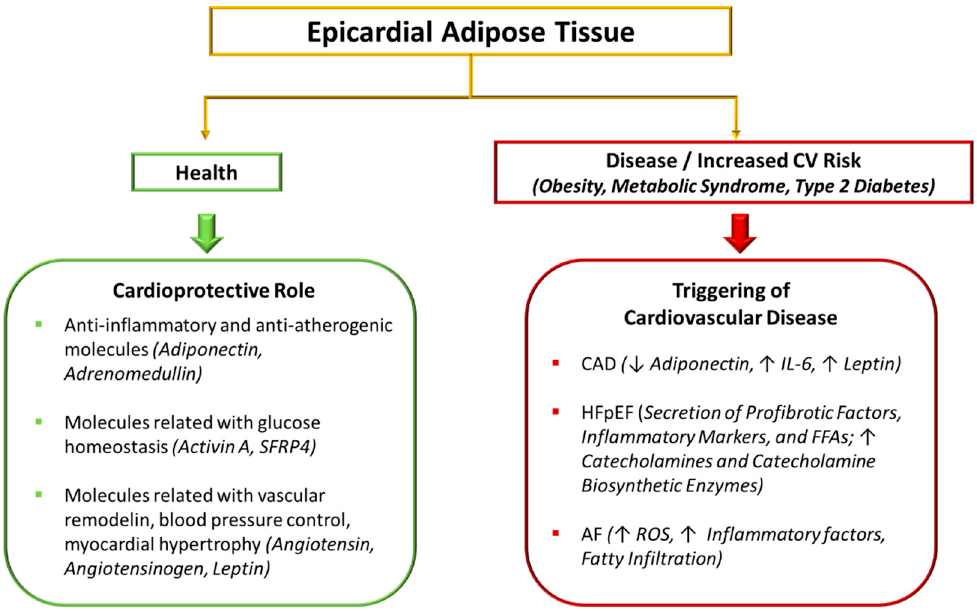
Figure 2. Mechanisms and mediators of beneficial and deleterious effects of epicardial adipose tissue on cardiovascular risk. In healthy conditions, EAT shows protective functions by secreting cardioprotective adipokines, including anti-inflammatory and anti-atherogenic molecules (e.g., adiponectin and adrenomedullin), molecules related with glucose homeostasis (e.g., activin A and SFRP4), and molecules involved in vascular remodeling, blood pressure control, myocardial hypertrophy and adipogenesis (e.g., angiotensin, angiotensinogen, leptin). Under specific pathological conditions, including obesity, metabolic syndrome and type 2 diabetes, the beneficial properties of EAT might be impaired, and EAT might thus promote the development of cardiovascular disease, including CAD, HF, and AF, through multiple molecular mechanisms: reduced expression of adiponectin, increased expression of IL-6 and leptin, secretion of profibrotic factors, inflammatory markers, and FFAs, increase in catecholamine levels and in catecholamine biosynthetic enzymes, augmented ROS production, and fatty infiltration of the atrium. AF, atrial fibrillation; CAD, coronary artery disease; EAT, epicardial adipose tissue; FFAs, free fatty acids; HF, heart failure; ROS, reactive oxygen species; SFRP4, secreted frizzled-related protein 4 ; ↑ increased; ↓ decreased.